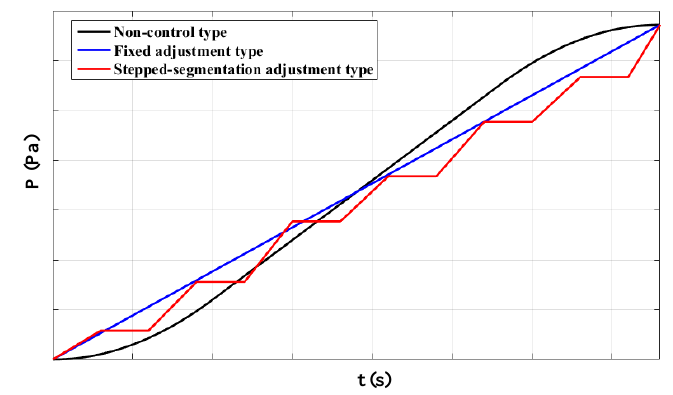
Energies 2020 , 13 , x FOR PEER REVIEW Figure 2. Three typical air pressure adjusting curves. Figure 2. Three typical air pressure adjusting curves.